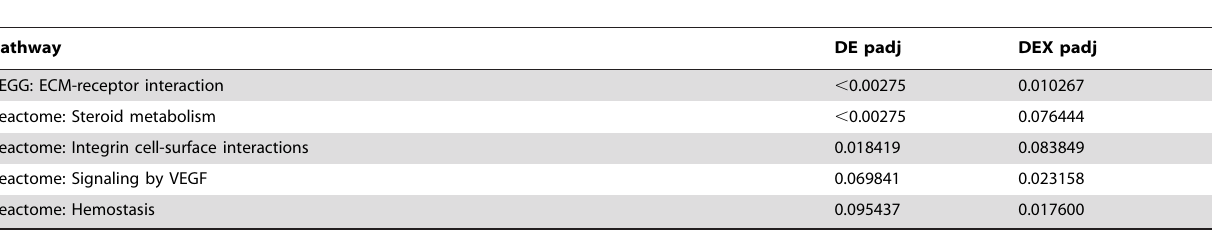
Table 6. Pathways enriched for differentially expressed genes and for differentially spliced genes in the RNA-Seq data.